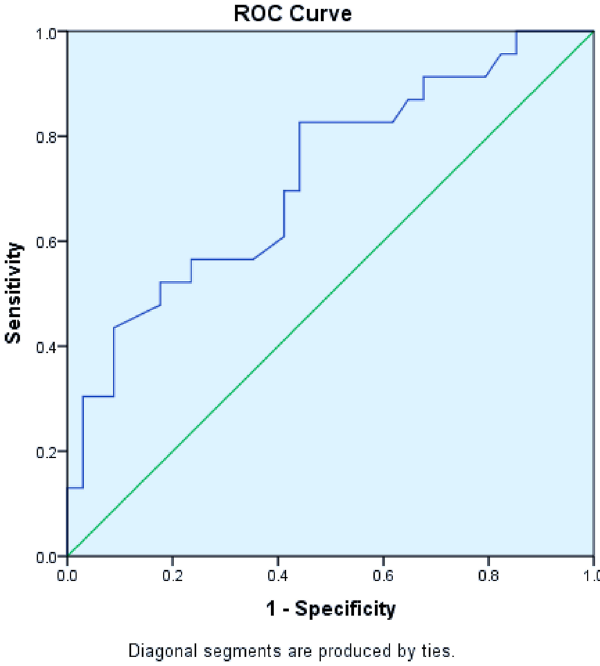
Figure 3. AUROC of the iscorEB when used to predict moderate to severe malnutrition.